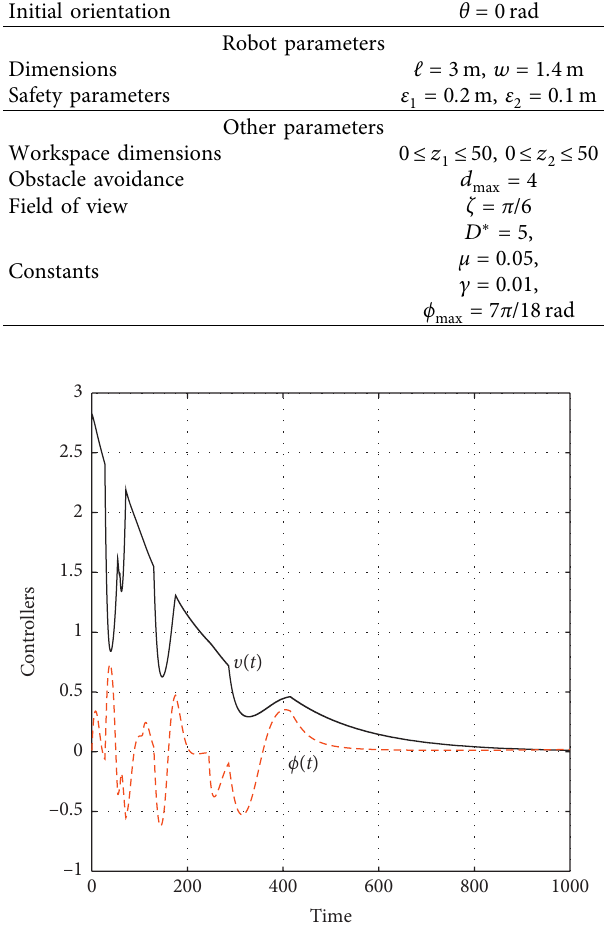
Figure 12: Evolution of controllers, v ( t ) (solid line) and ϕ ( t ) (dotted line), for the trajectory shown in Figure